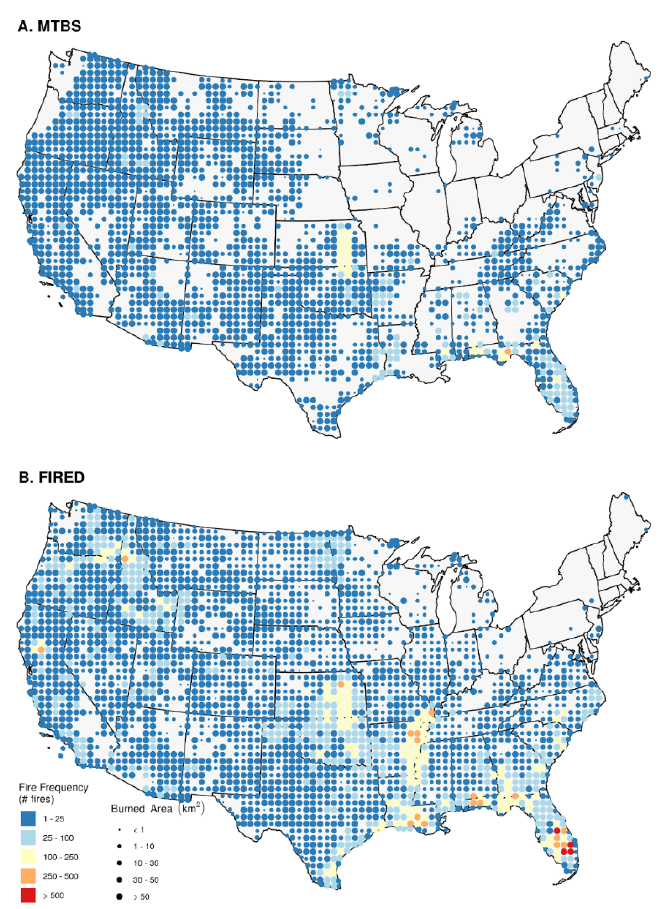
Table 5. Confusion matrix for comparison between FIRED events and MTBS events, where both products were above the MTBS-determined size threshold of 404 ha in the western US and 202 ha in the eastern US. The last column provides the number of small events that were delineated by FIRED below these size thresholds.